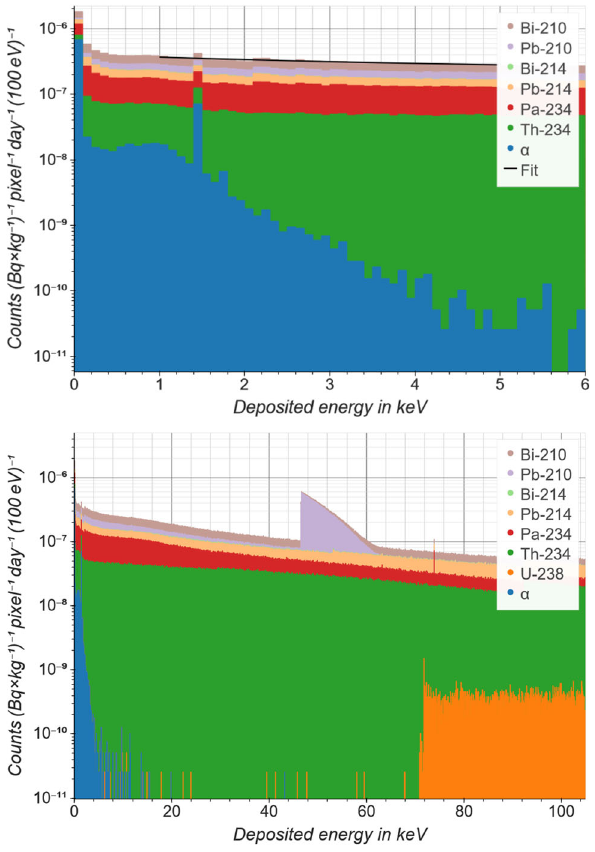
Fig. 5 Simulated spectrum of deposited energies in the MMC absorberscausedbythesurface-distributed 238 U-chainontheabsorbers. The fractions due to the single nuclides of this chain are colored. The α -particlescanbeemittedbyanyisotope.Forlowenergies,thesummed spectrum has no structures. Nuclides decaying by an α -decay change the spectrum only minor at low energies. At higher energies however, these nuclides provide many features escape,butalsoX-rayemittedbythedaughternuclides.From 234 Pa, the 43keV gamma level and from 214 Pb, excited